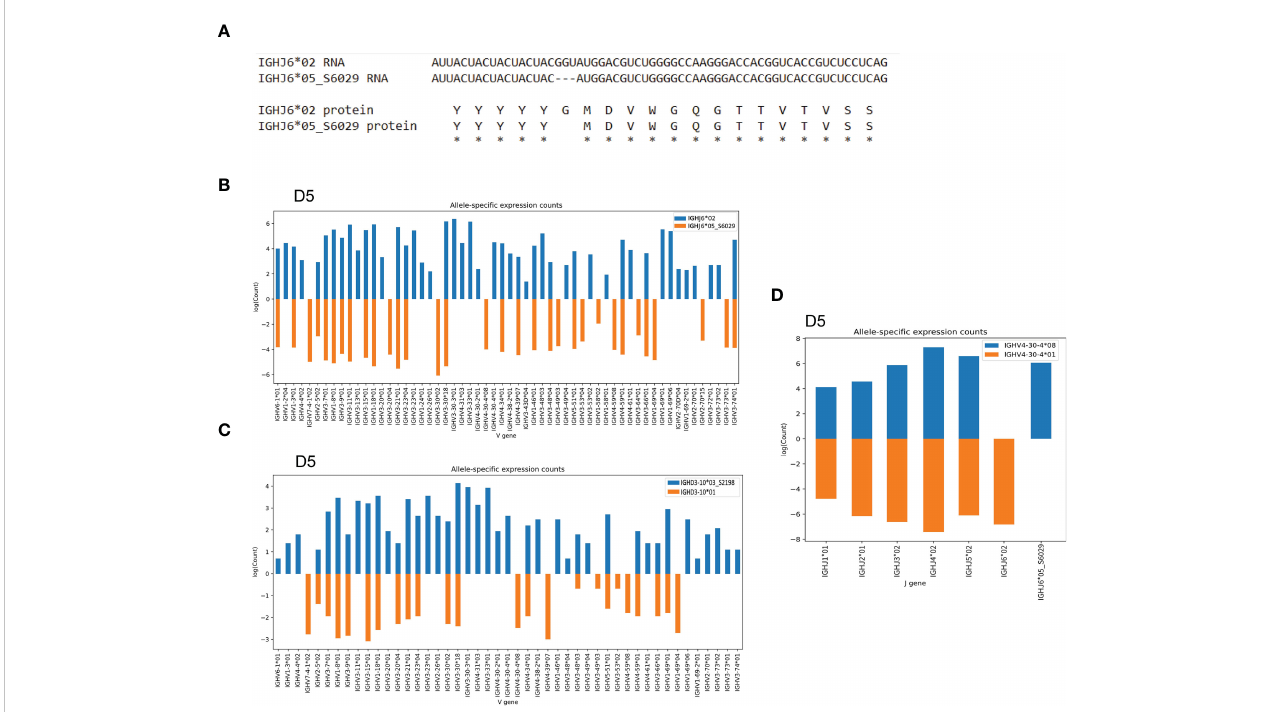
FIGURE 4 Novel IGHJ6 allele as anchor for haplotyping (A) The alignment shows the deletion of a base triplet in the novel IGHJ6*05_S6029 results in a deletion of a glycine residue at protein level. (B) The novel IGHJ6*05_S6029 variant in combination with the regular IGHJ6*02 allele can be used for IGHV gene haplotyping in the D5 individual. (C) Case D5 can be haplotyped based on IGHD3-10 gene heterozygosity. (D) The J6 alleles are haplotypable using heterozygous IGHV4-30-4 alleles as anchors, showing the clear separation of the IGHJ6*05_S6029 allele to a different chromosome compared to the IGHJ6*02